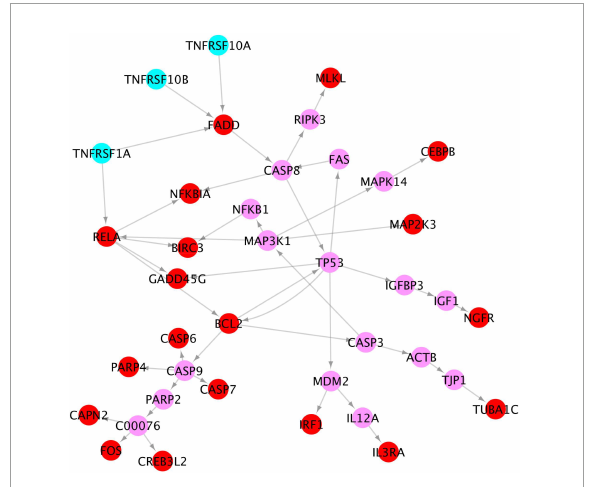
FIGURE7 Signaling cascades, causing neuron degeneration, from the 3 TNF receptors (cyan) to the upregulated genes (red) in TNF and apoptosis signaling pathways via the linking genes